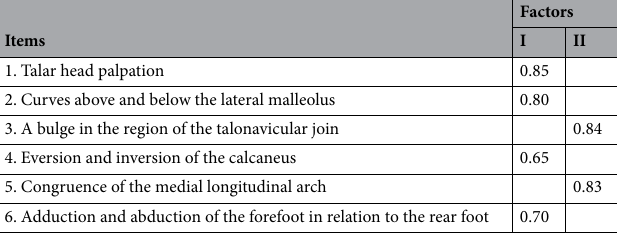
Table 5. Factor loadings from EFA.